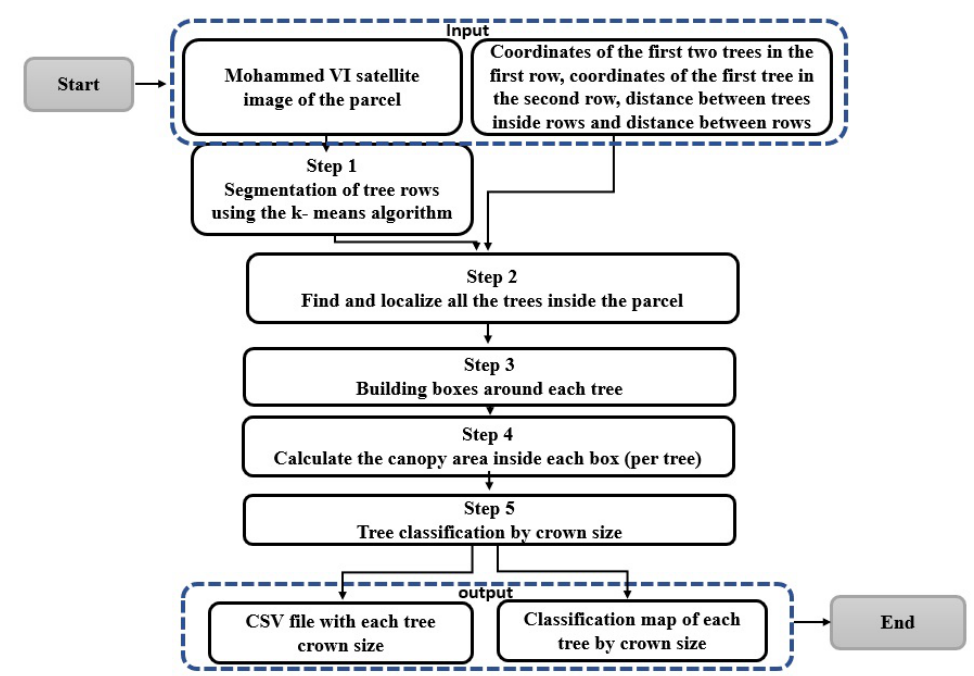
Figure 4. Flowchart of the